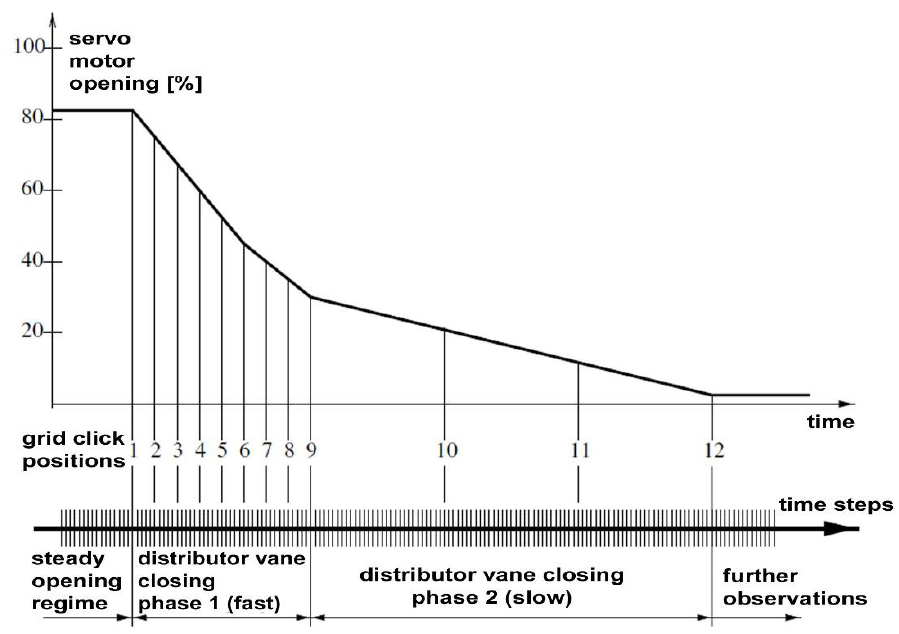
Figure 6. Study for the second slope closing influence [89].